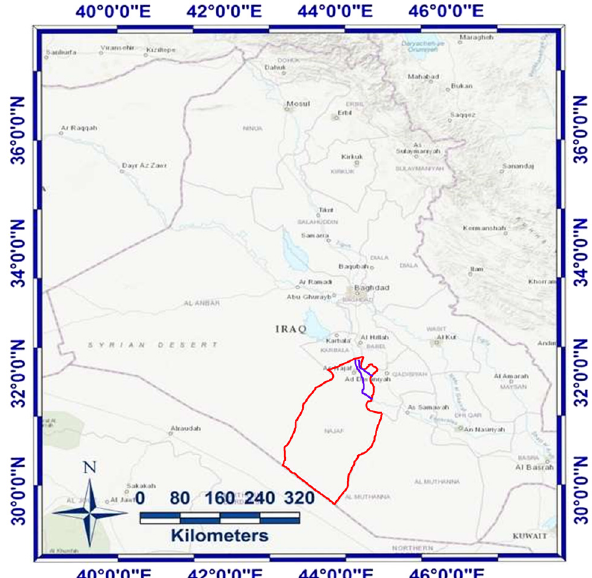
Figure 1: Al - Najaf Governorate with the Euphrates river branches ( Al - Kufa and Al - Abbasiya )